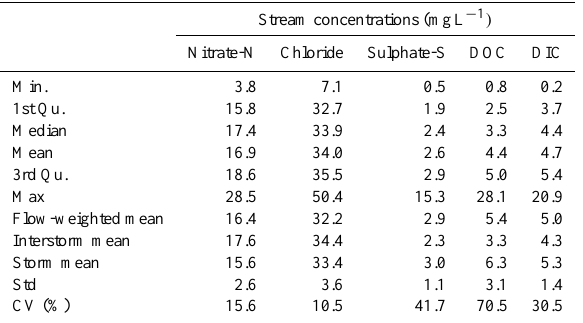
Table 1. Summary statistics for 10yr of daily stream concentrations of nitrate, chloride, sulphate, dissolved organic carbon (DOC) and dissolved inorganic carbon (DIC) from the Kervidy-Naizin catch- ment ( n = 2229). (Std–standard deviation; CV–variation coeffi- cient).